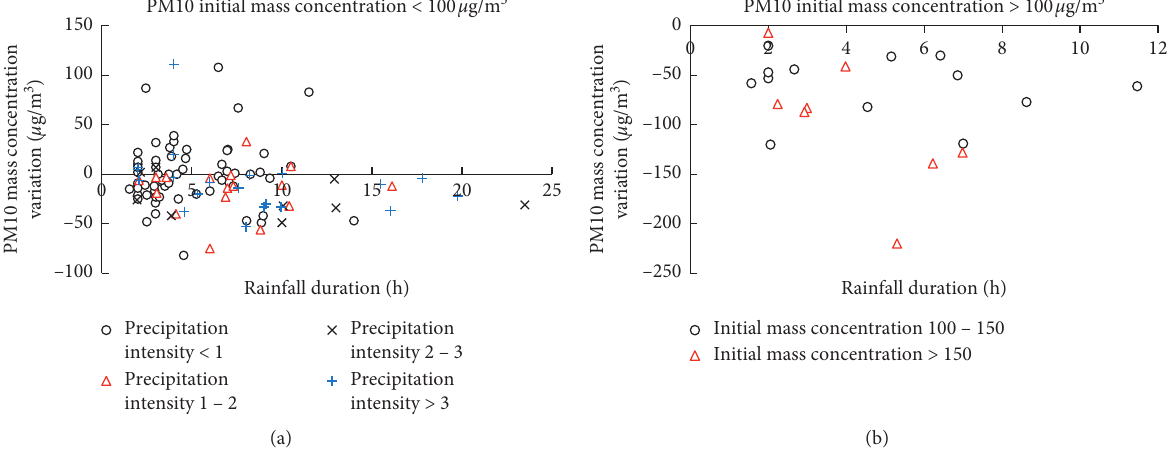
Figure 10: Relationship between the change of PM10 concentration and the duration of precipitation.